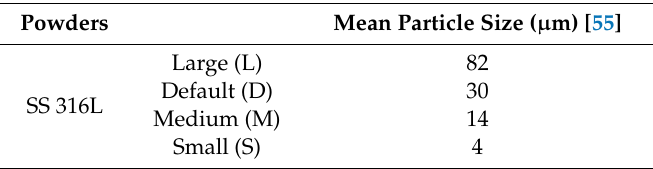
Table 4. List of SS316L powder their average particle